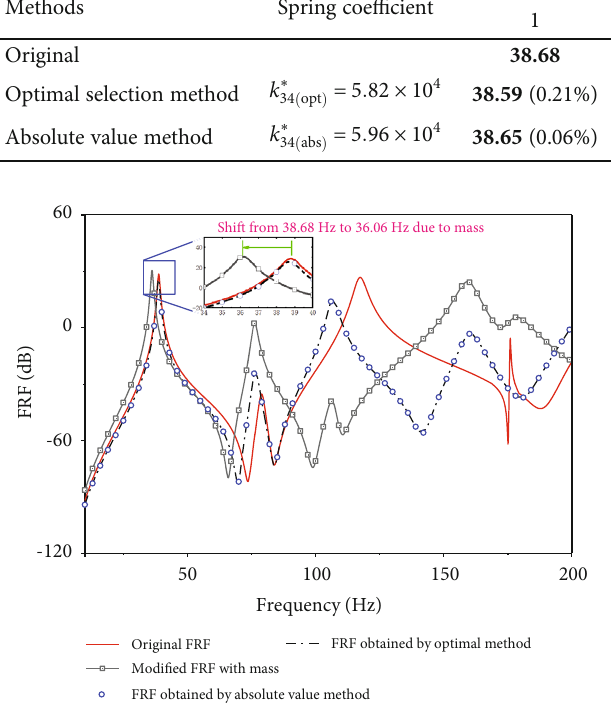
Figure 14: Comparison of original and modi fi ed FRF h